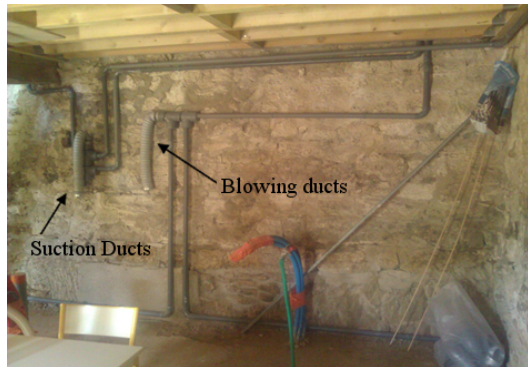
Figure 8. Instrumentation of a semi-buried wet wall.